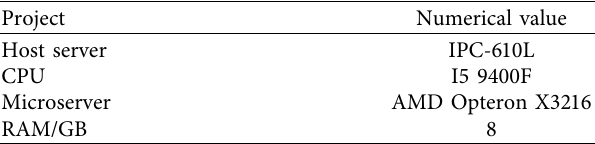
Table 1: Experimental